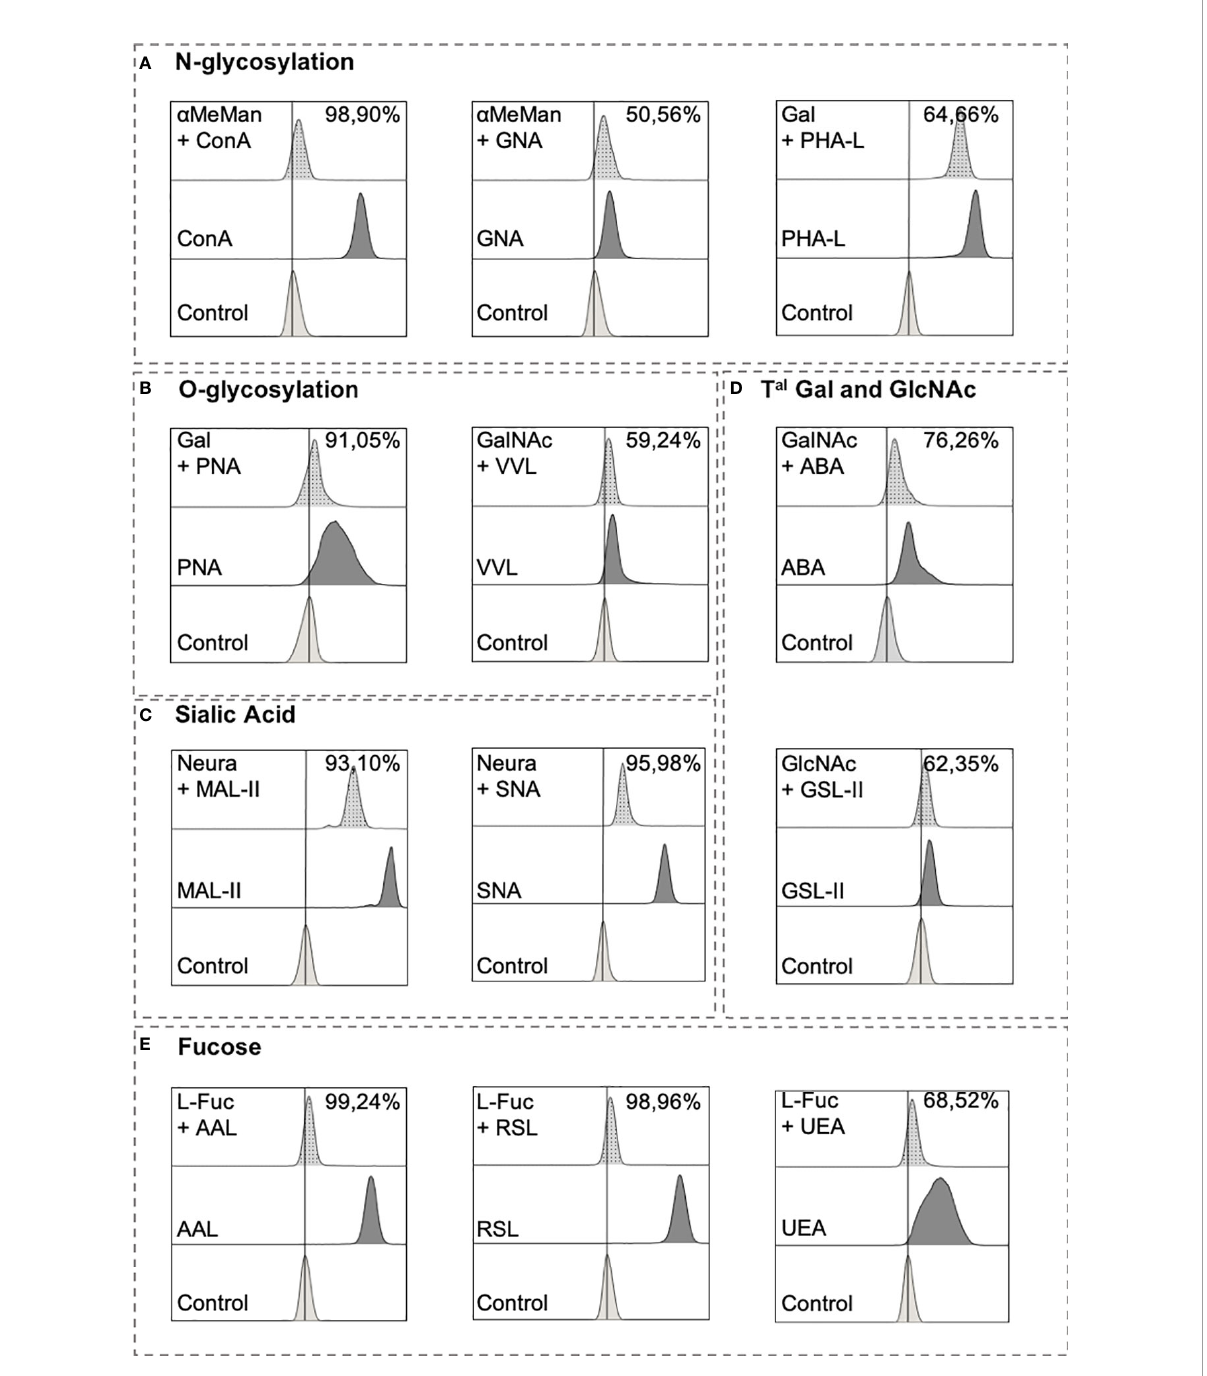
FIGURE 2 Lectin inhibitory tests.Lectins (except MAL-II and SNA) (Table 2) were pre-incubated with a PBS solution containing monosaccharides for 15 min at 4°C with PBS before being used to stain Ramos cell line for 15 min at 4°C. After 2 washes in PBS, cells were incubated for 15 min at 4°C with 5 µg/mL streptavidin-FITC. After wash with PBS, cells were analyzed using Beckman Coulter Cyto fl ex S. For ConA and GNA, inhibition test consists in pre-incubating lectins with a -methyl-mannoside (360mM). PHA-L and PNA were pre-incubated with 200 mM of galactose (Gal). N- acetylgalactosamine (GalNAc) was pre-incubated at 83mM with VVL and ABA. GSL-II was pre-incubated with 200 mM of N-acetylglucosamine (GlcNAc) and 200mM of L-fucose (L-Fuc) was used for AAL, RSL and UEA lectins. For MAL-II and SNA, cells were treated with neuraminidase (0.05 U/mL) and washed twice followed with a regular staining procedure. Results are presented as followed: N-glycosylation in (A) , O-glycosylation in (B) , Sialylation in (C) , Terminal (T al ) Gal and GlcNAc on N and O-glycosylation in (D) , and Fucosylation in (E)